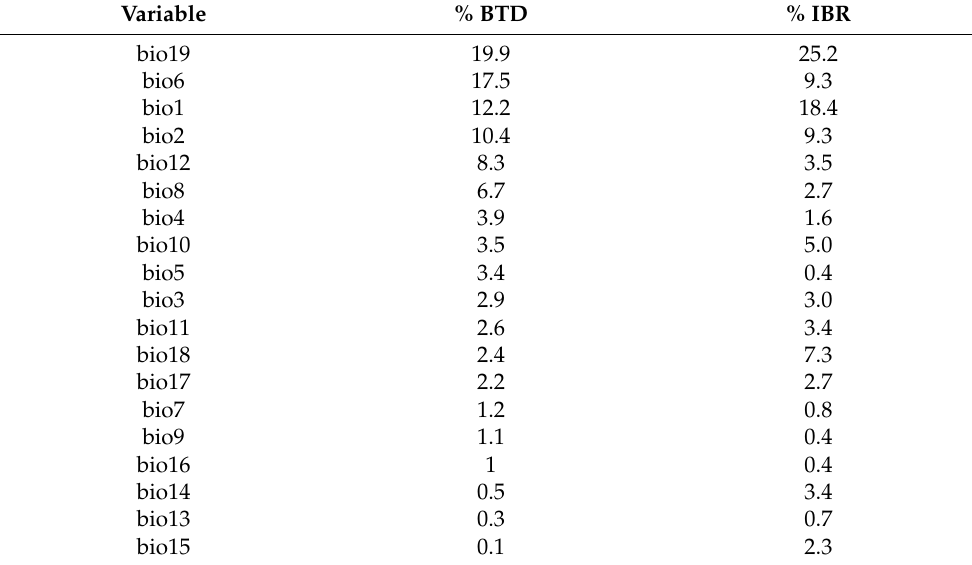
Table 3. Variable relative importance for the BRT